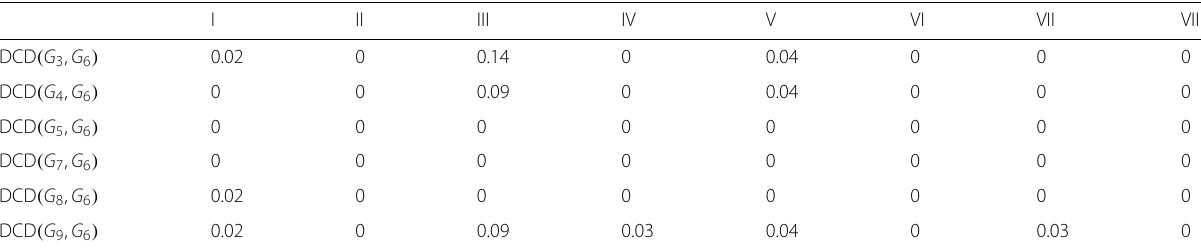
Table 1 DCD records for evaluation of K defined in Eq.